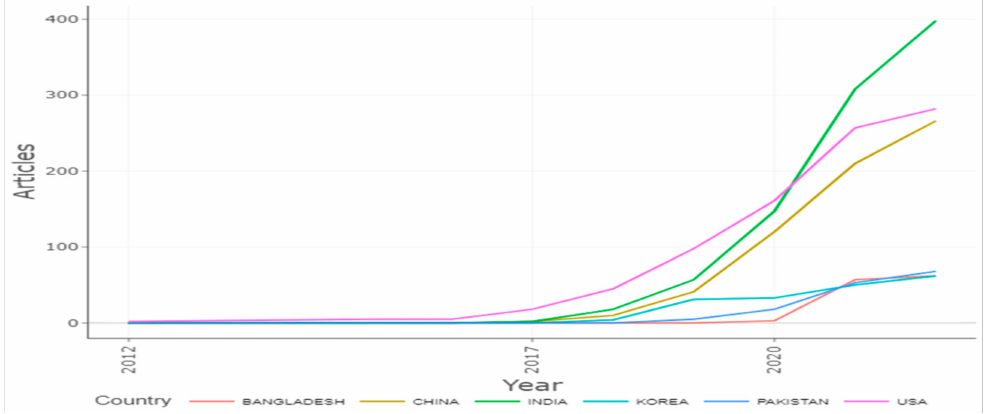
Figure 12. Country’s production over